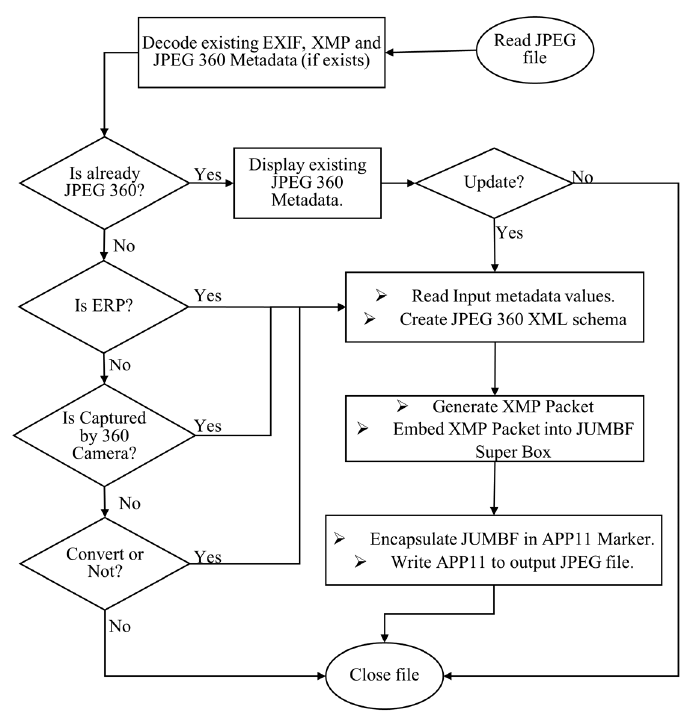
Figure 6. Workflow of the proposed JPEG 360 converter.